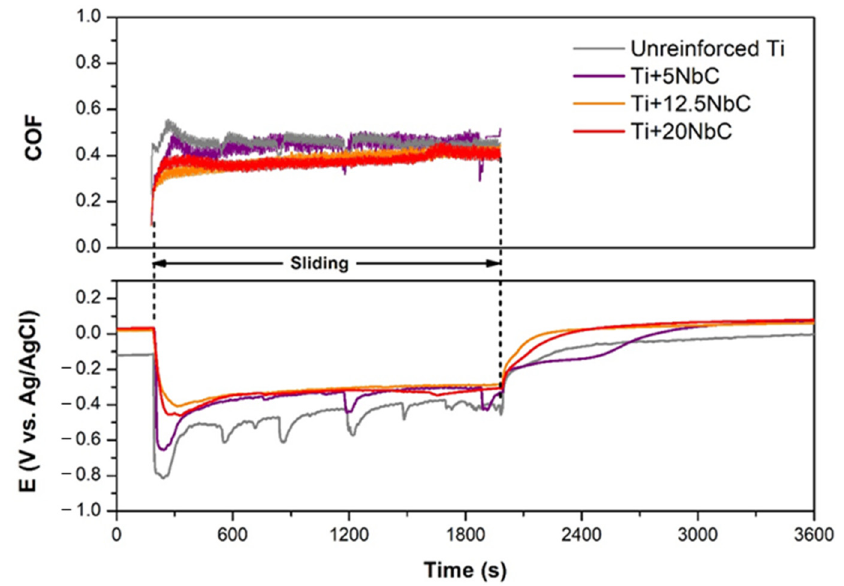
Figure 6. COF and potential evolutions during tribocorrosion tests performed under OCP.